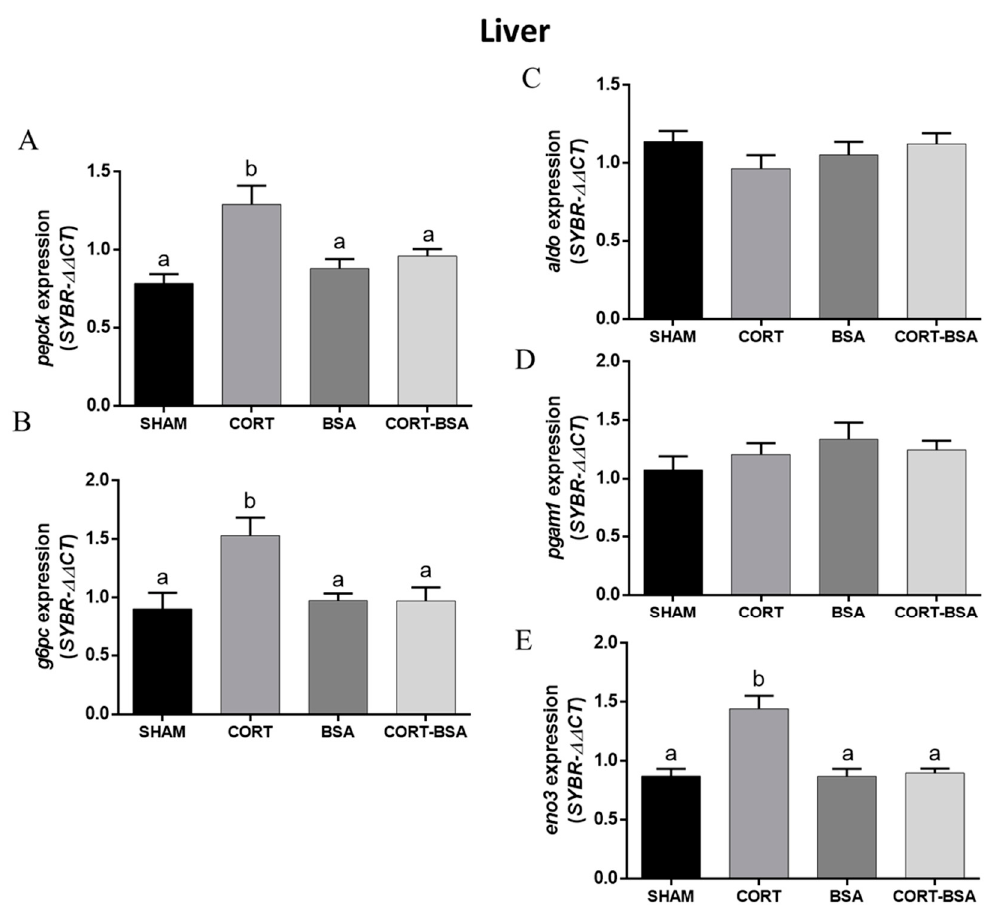
Figure 4. Glucose-metabolism related genes expression in liver. Expression of gluconeogenesis-related genes pepck ( A ) and g6pc ( B ), and glycolysis-related genes aldo ( C ), pgam1 ( D ), eno3 ( E ) were evaluated in vehicle (sham-control), cortisol, BSA and cortisol-BSA administered fish at 72 h post-treatment. Results are expressed as mean ± SEM ( n = 8). Different letters indicate significant differences between groups ( p value < 0.05). All data were analyzed using one-way ANOVA and Tukey’s HSD as a post hoc test.